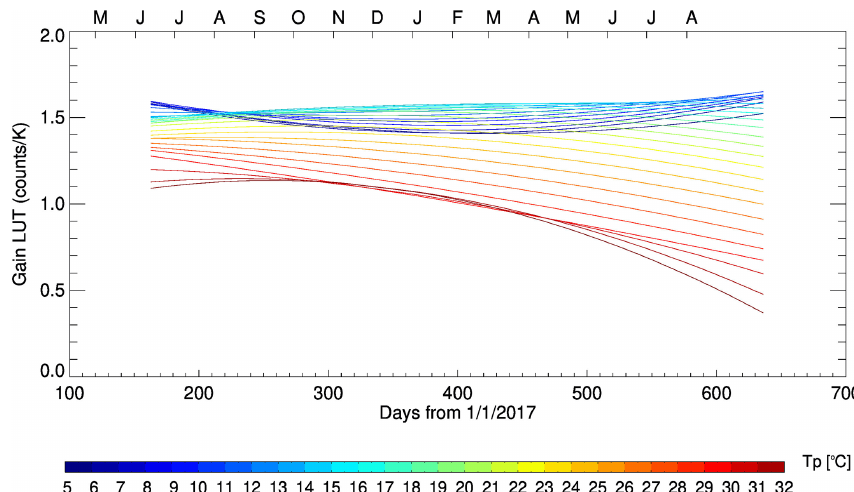
Figure 6. Lookup table (LUT) of the gain model as a function of Tp 4 and Julian